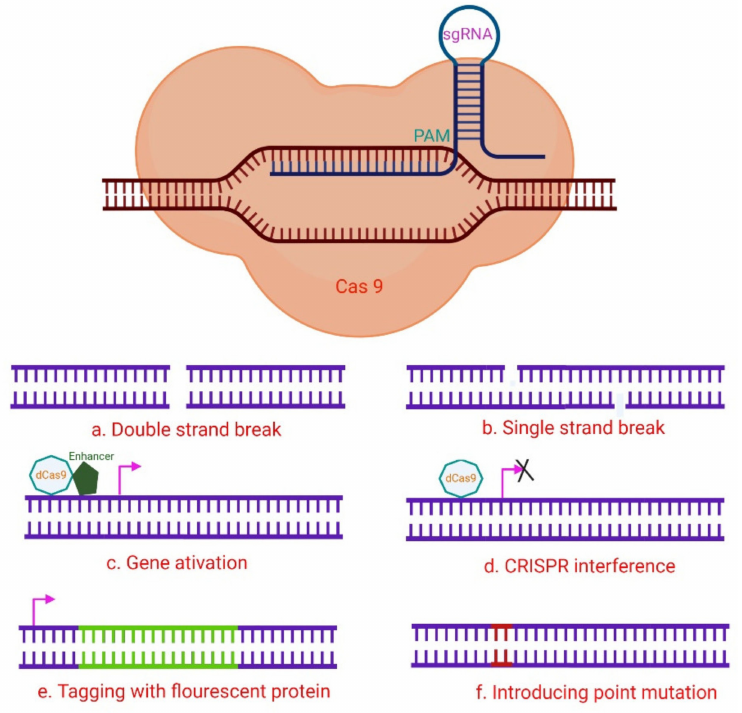
Figure 3. A hypothetical CRISPR/Cas9 experimental design. The numerous Cas9 variants available have made it easier to perform a variety of genomic modifications, including ( a ) induction of DNA DSB utilizing wild-type Cas9; ( b ) Cas9 nickase is used to induce DNA SSBs, in which two neighboring gRNAs target distinct strands, resulting in a DSB and subsequent NHEJ (non-homologous end joining) response; ( c ) The target gene is activated via CRISPR activation utilizing dCas9 and transcription activator fusion with transcription-activating proteins such as VP64 that target the promoter region. ( d ) By steric hindrance, CRISPR interference with dCas9 or dCas9-BFP decreases gene expression, and the dCas9-KRAB fusion epigenetically marks the gene for transcriptional repression. These methods can be used to stop gene transcription transiently. ( e ) A donor template that includes a fluorescent protein gene with homology regions can be used to drive homology-directed repair (HDR). By cutting at the target location with Cas9-WT or Cas9 nickase, it is possible to tag genes with fluorescent proteins. In another setting, the donor plasmid might include a selectable marker for determining whether knock-in events do occur. ( f ) Cas9-WT or Cas9 nickase also initiate the introduction of point mutations via HDR from an ss oligonucleotide. Adapted from [47] and generated using BioRender